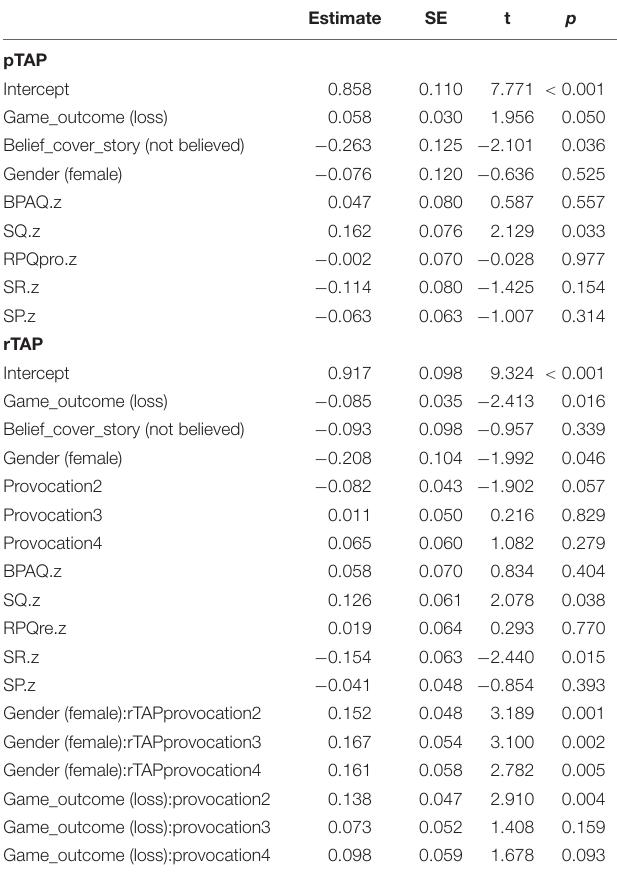
TABLE 2 | Parameter estimates from the generalized linear mixed-effects model analyses for aggression choices in the pTAP and rTAP. Estimate